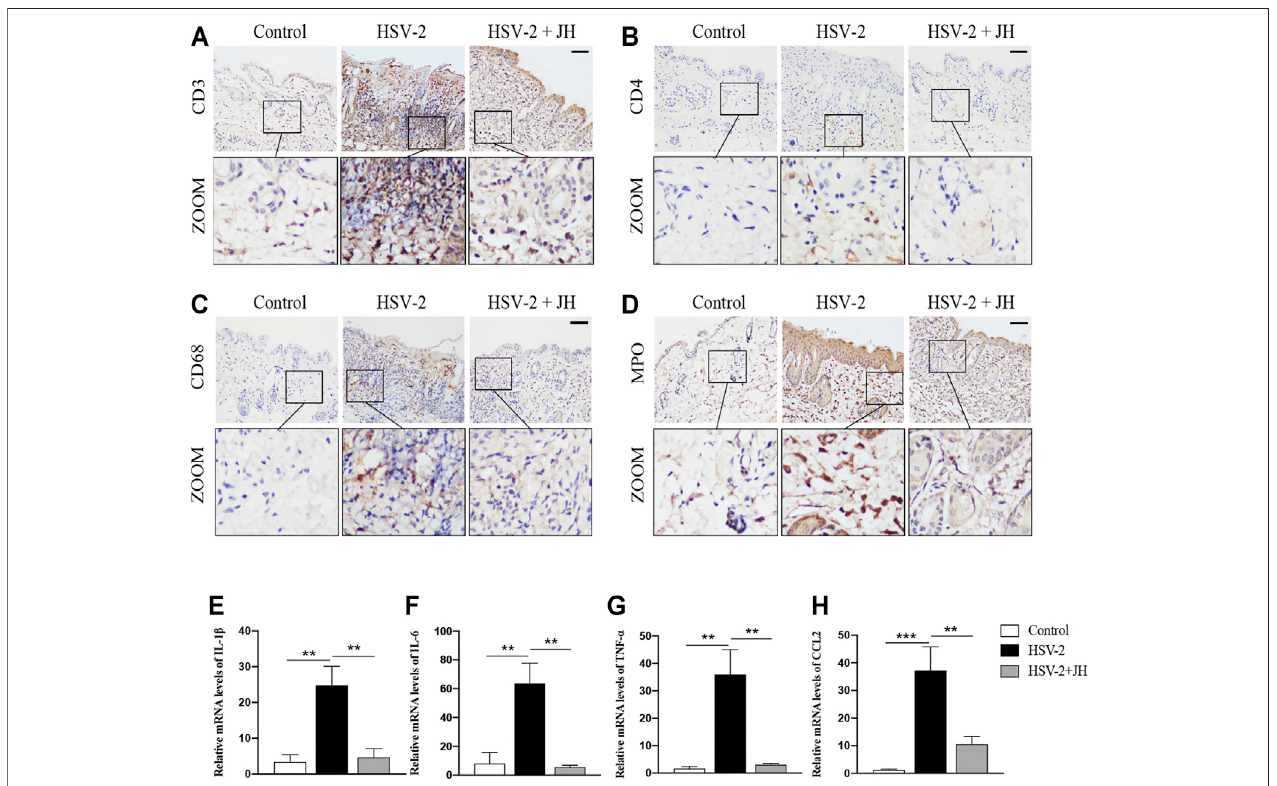
FIGURE 3 | JZ-1 administration inhibits in fl ammatory response in HSV-2-induced GH. (A – D) Representative immunohistochemistry staining for CD3, CD4, CD68 and MPO in vulva of different groups. Scale bar, 100 μ m. (E – H) The mRNA levels of IL-1 β , IL-6, TNF- α and CCL2 in vulva of different groups. All data are presented as means ± SEM. p < 0.05 (*); ( n (cid:2)